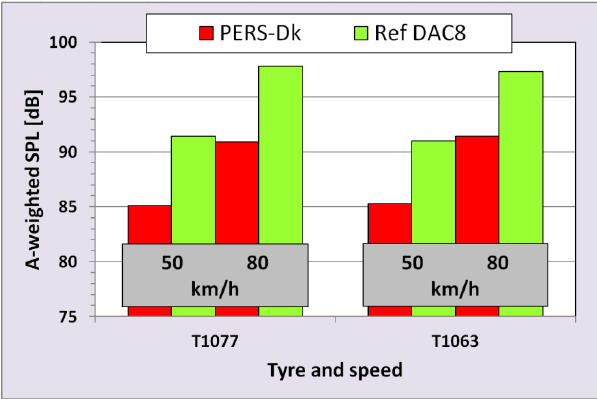
Figure 7. A ‐ weighted SPL measured by the CPX method on test sections in Denmark.